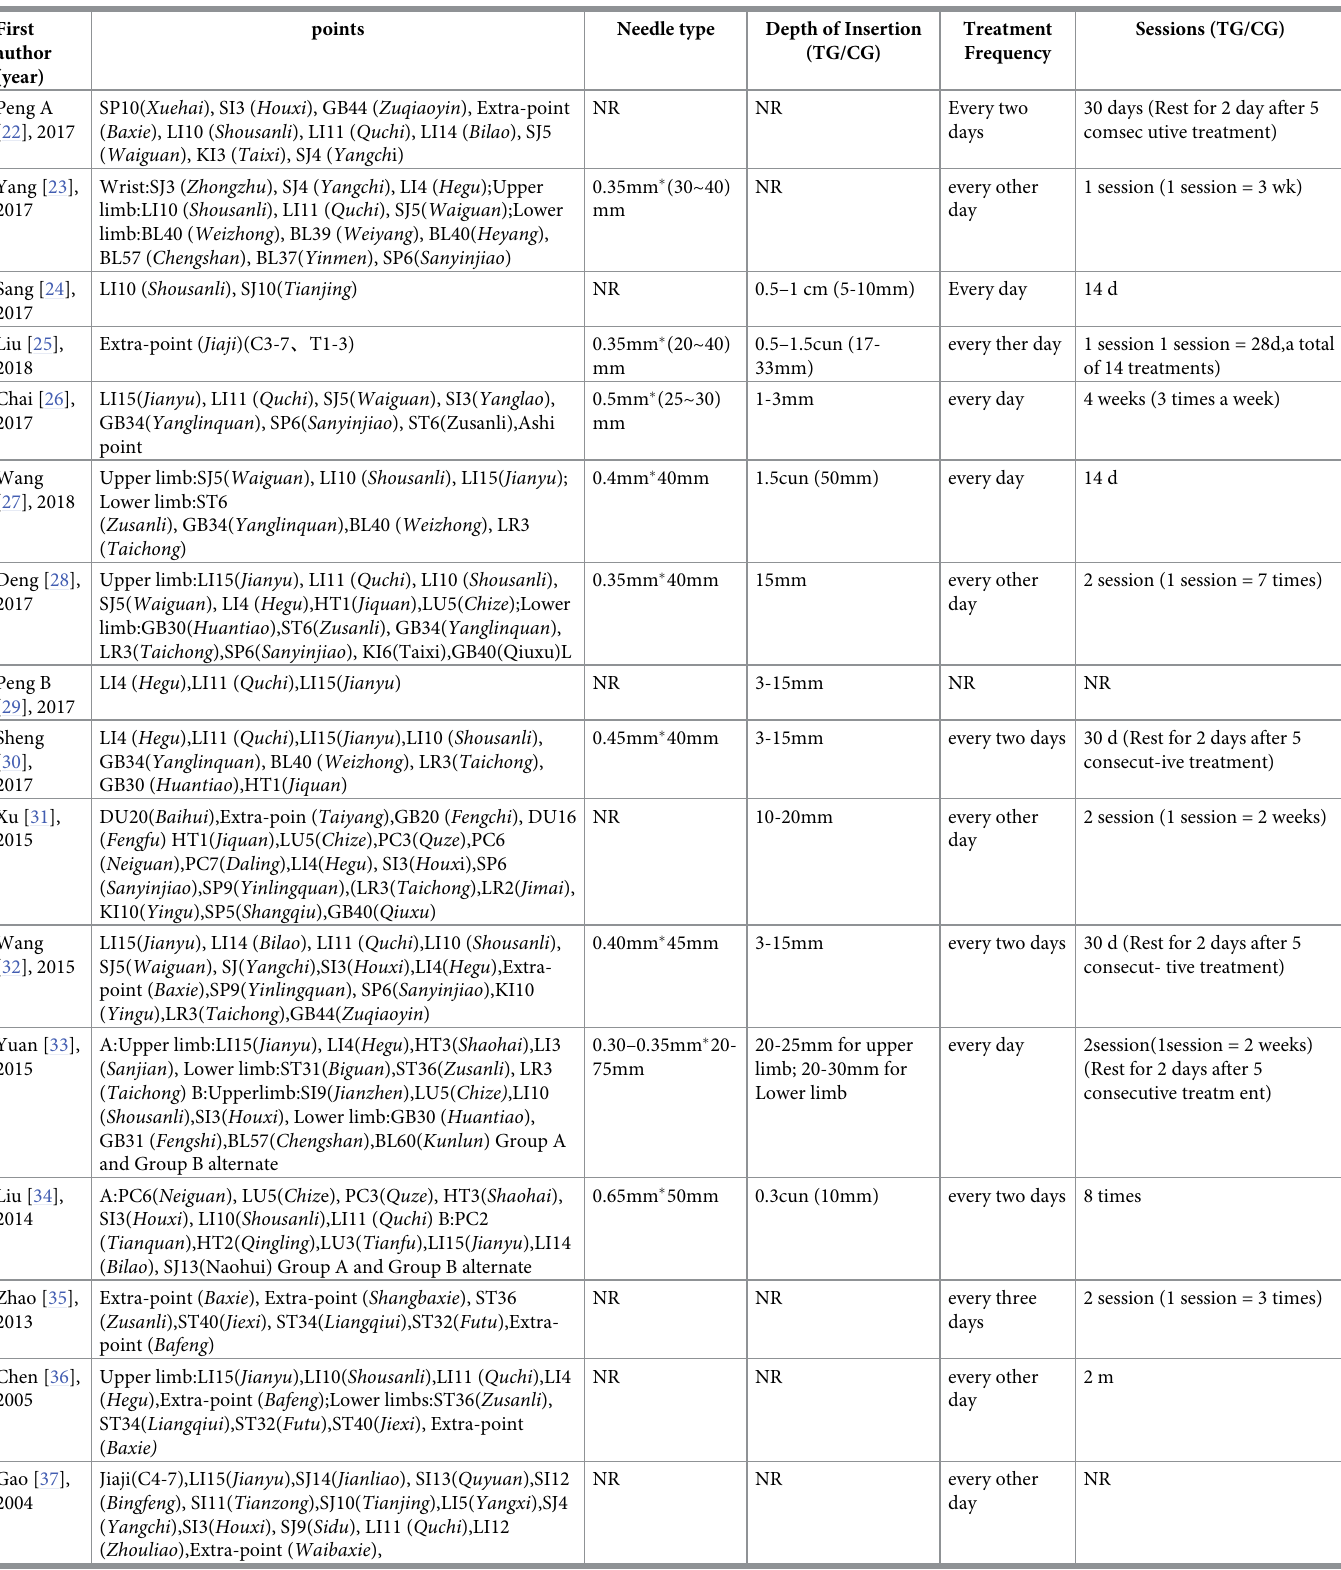
Table 2. Details of experimental